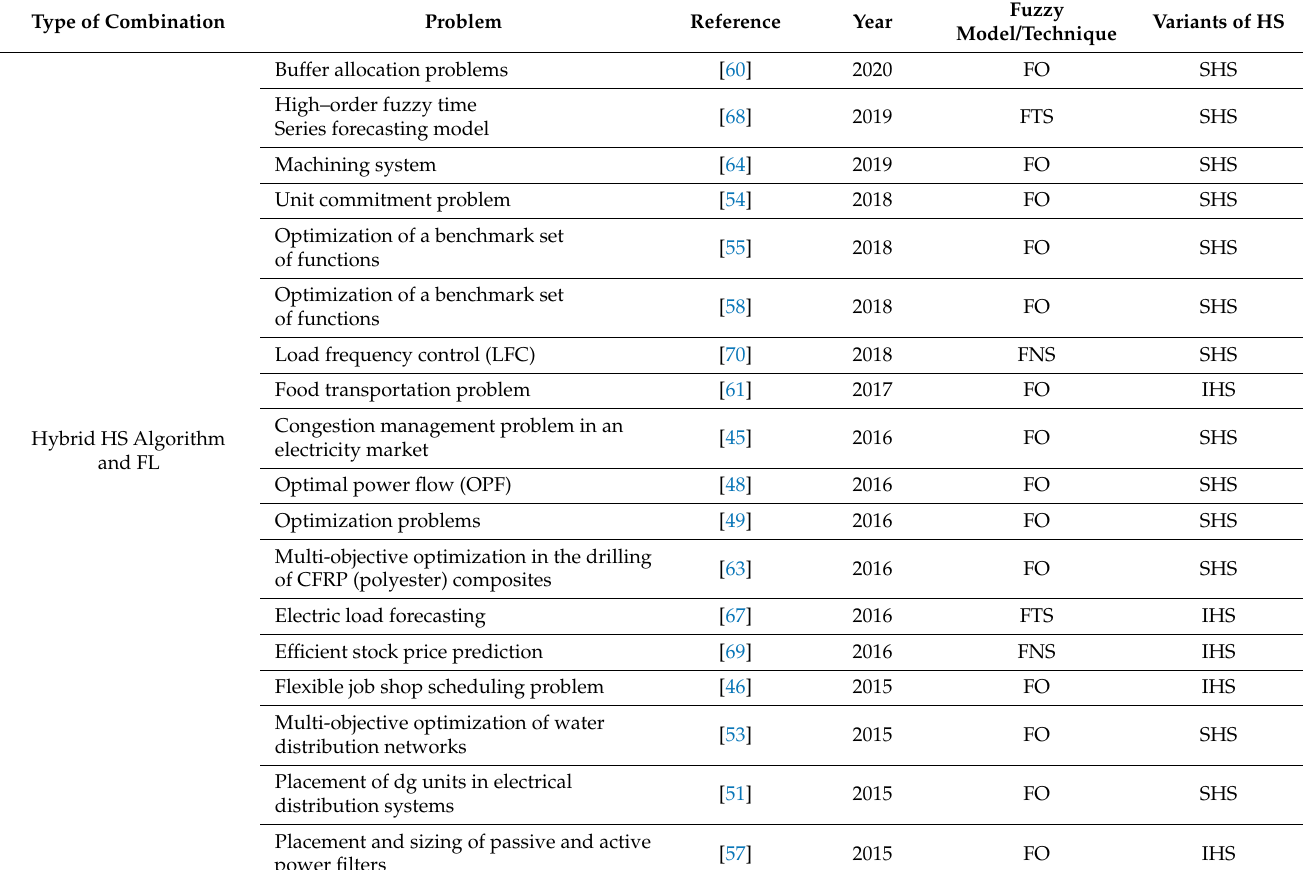
Table 8. Combination type of HS with the